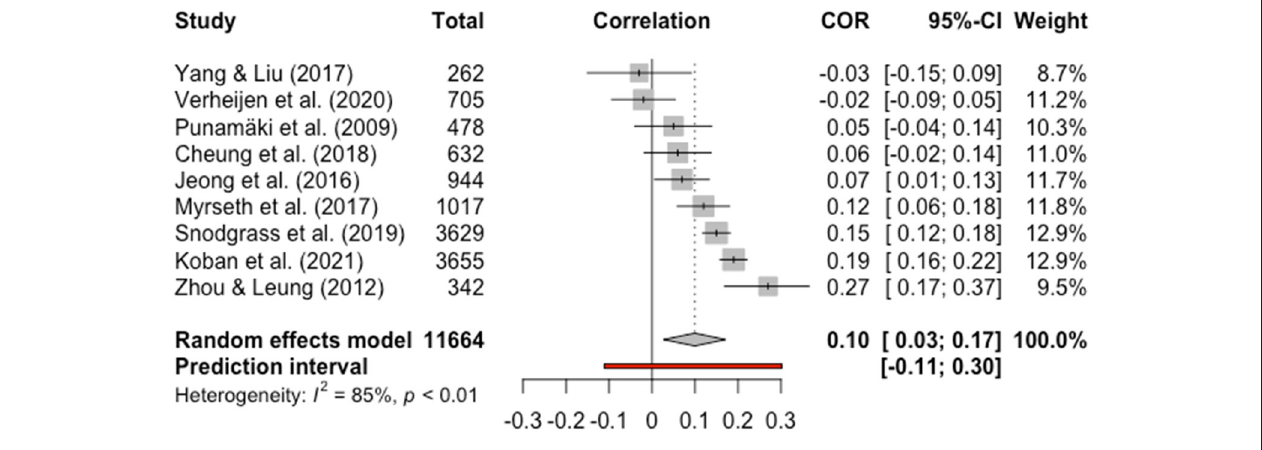
FIGURE 2 | Forest